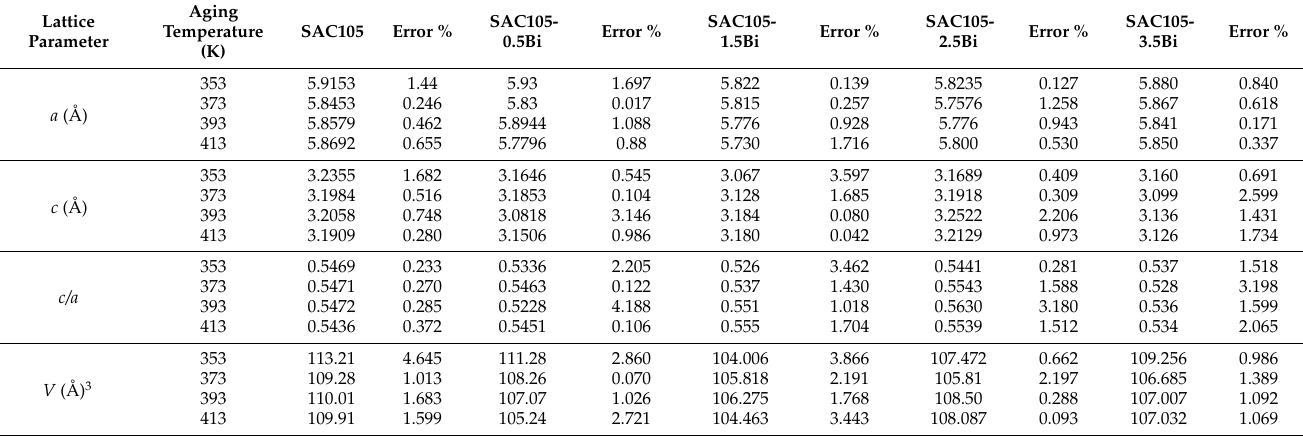
Table 2. The calculated crystalline lattice parameters a , c , c/a ratio, and the unit cell volume V for β-Sn matrix at different aging temperatures and various bismuth concentrations.